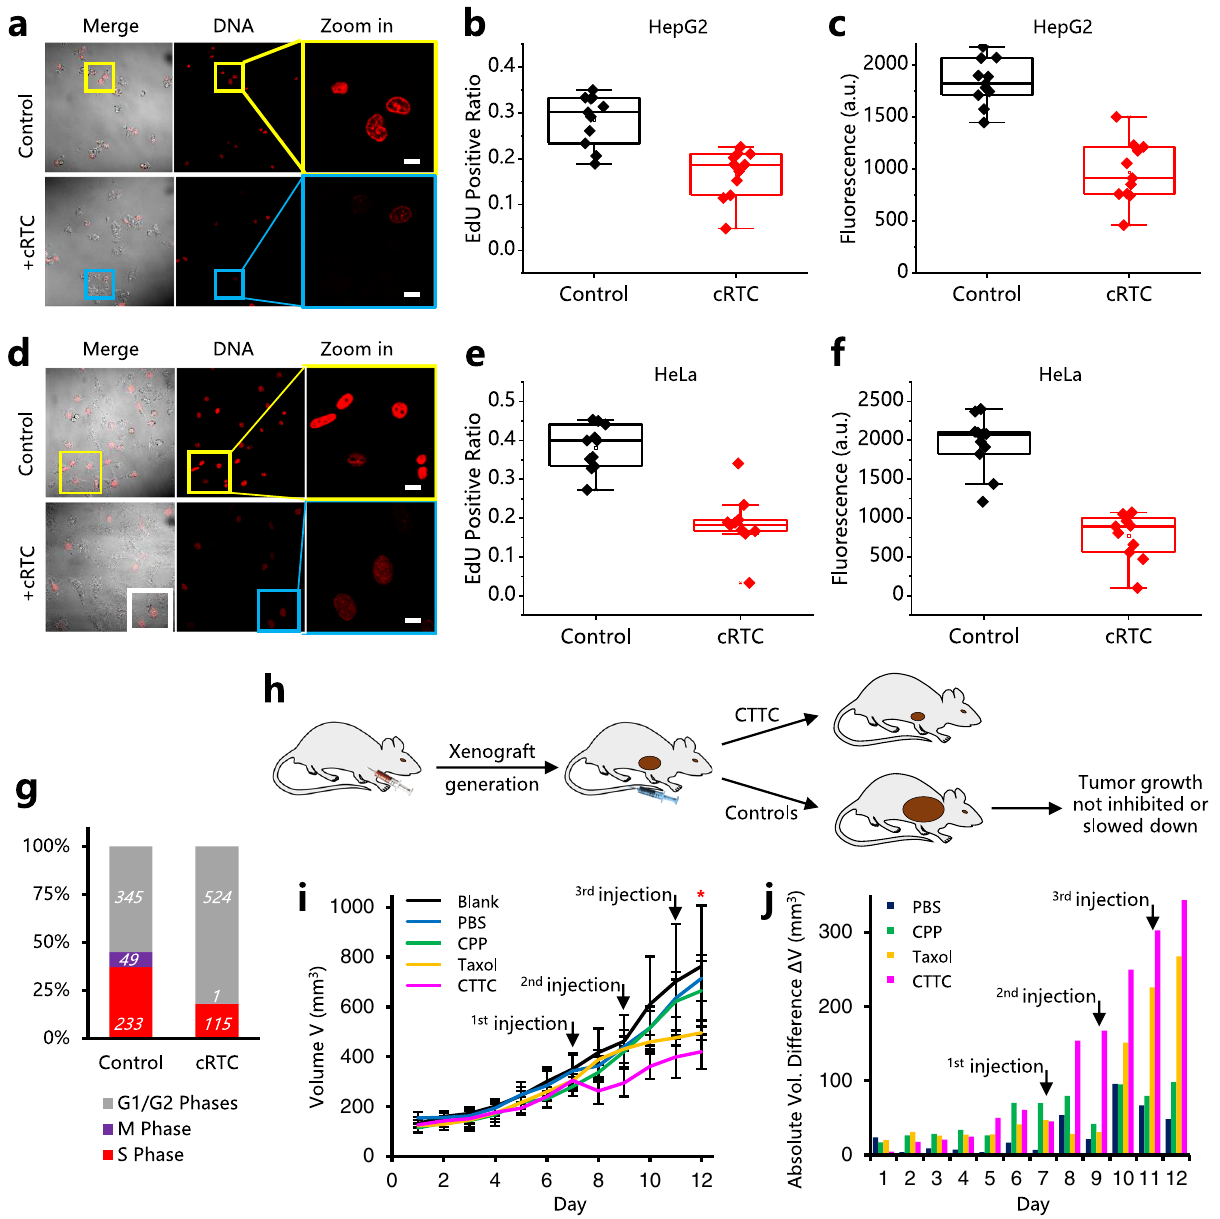
Fig. 6 | TPX2 SNACIP inducers effectively inhibit cancer cell proliferation via blocking cell cycle progression to M-phase, and suppress hepatocarcinoma cell tumor growth in vivo. a Representative confocal images of cRTC-treated (+cRTC, 10 μ M, 24h) and control HepG2 cells in the EdU cell proliferation assay. b Statistical analysis of EdU positive ratios of HepG2. c Statistical analysis of fl uorescence intensities of EdU positive HepG2 cells. d – f Same experiments as in ( a – c )forHeLacells. n =12cellsin b – c & e – f ,andseeMethodsfordescriptionofbox plots for b – c & e – f . g Percentage of each cell cycle phase of HeLa cells with or without adding cRTC;the totalcellnumberinallimaging fi elds ( n ≥ 10)at each